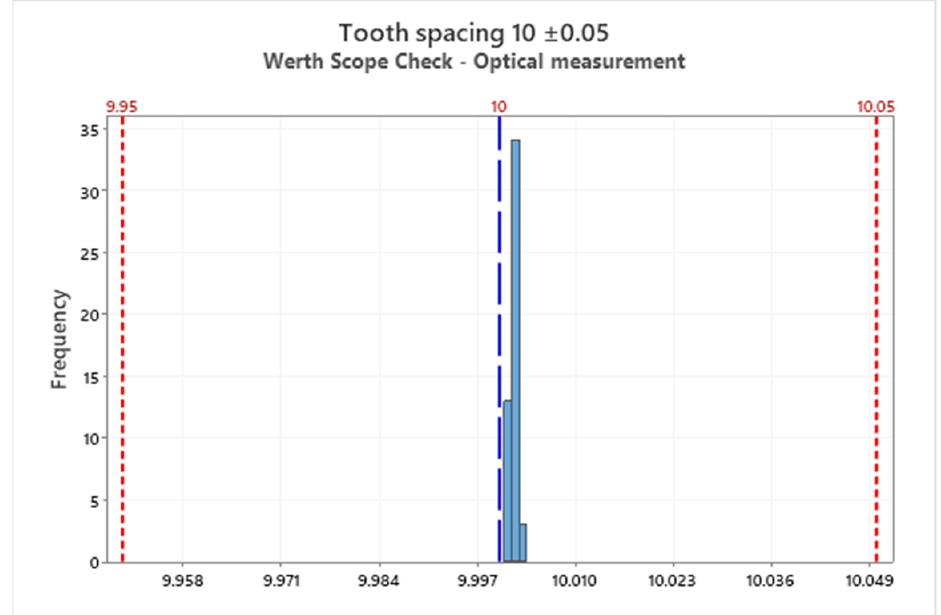
Figure 10. Tooth spacing 10 ± 0.05 mm—histogram from measurements obtained with the Multisensory Measuring Machine Werth Scope Check, values on x axis given in mm (own study).